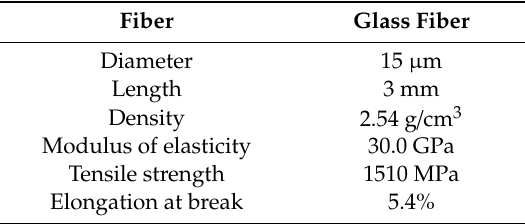
Table 3. Physical properties of the glass fiber.